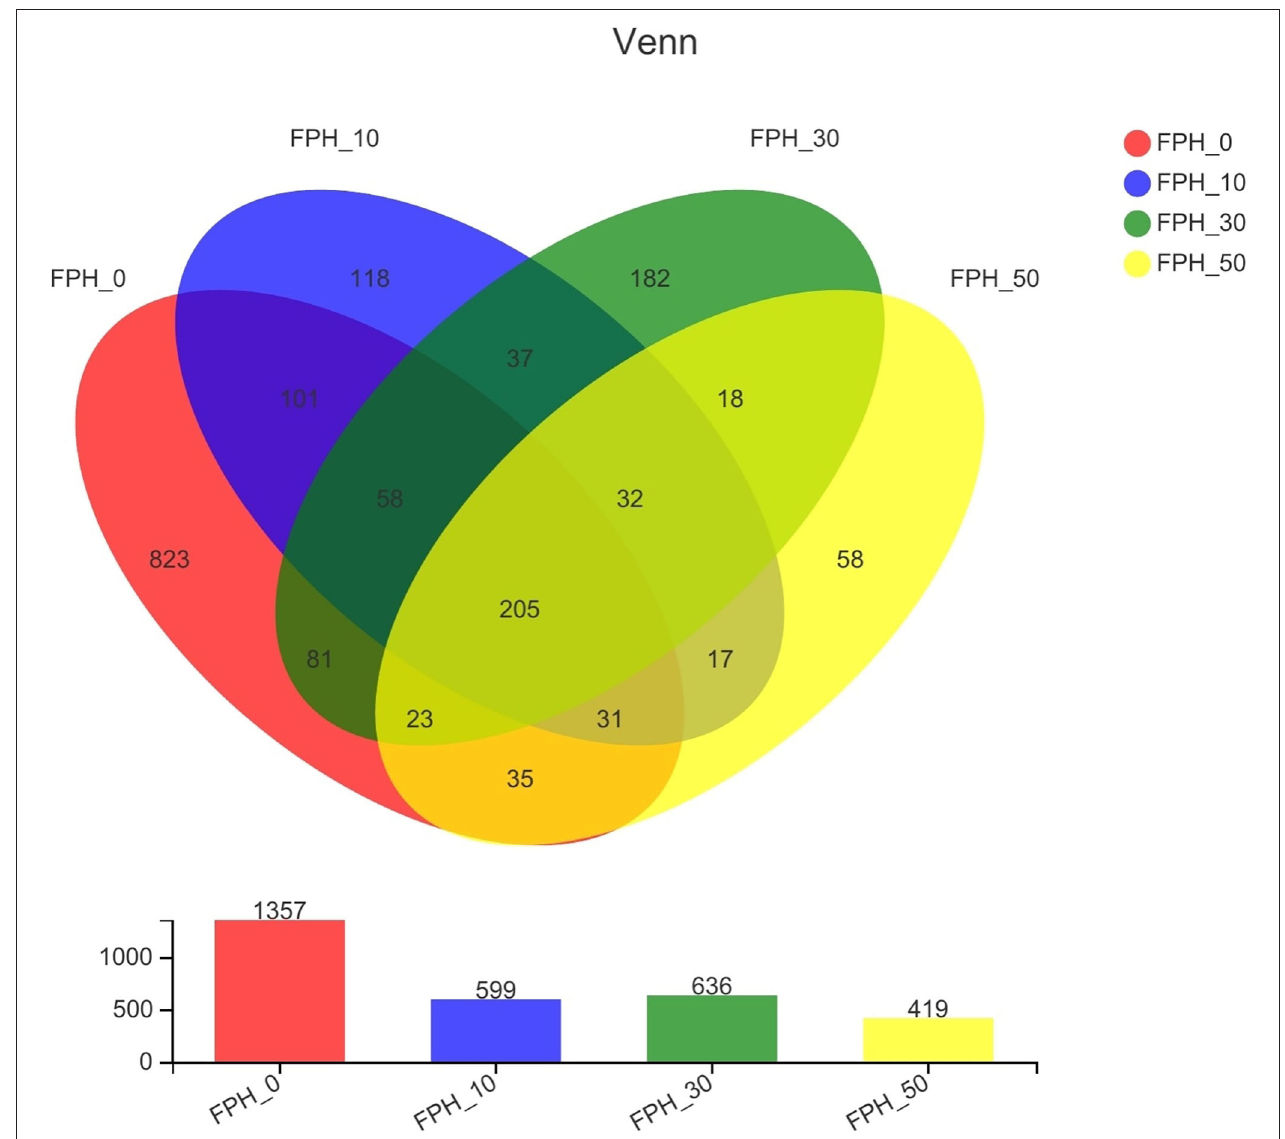
FIGURE 4 | The Venn diagram displays the overlapping and unique OTUs (operational taxonomic units) in largemouth bass ( Micropterus salmoides ) fed the diets containing different supplementation levels of fish protein hydrolysate